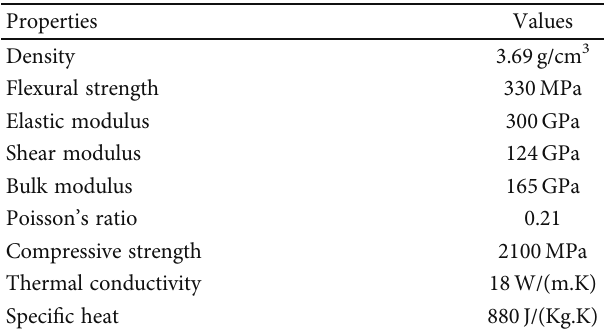
O nanoparticles. 2 3